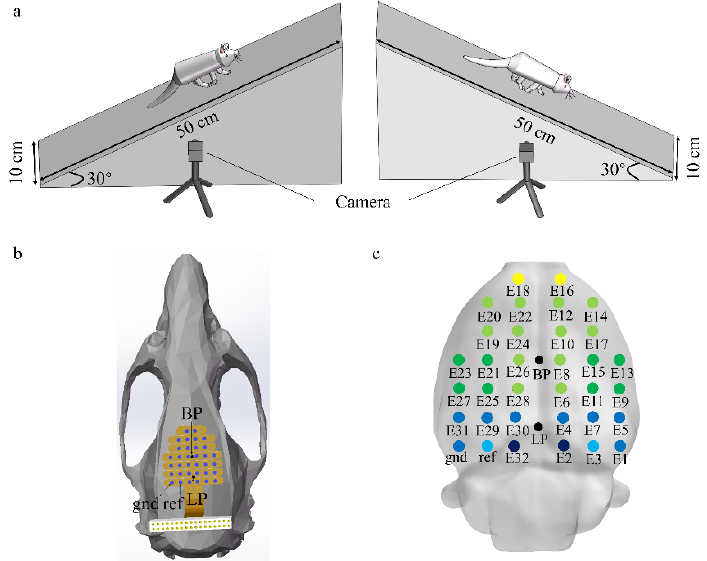
Figure 1. Recording setup and task conditions. ( a ) Characteristics of locomotor paradigms (upslope and downslope walking). ( b ) Electrode location on the rat skull surface; blue dots representing screws that attach the electrode array to the skull; BP represented the bregma point; LP represented lambda point. ( c ) Putative electrode positions on the rat brain, obtained using Brainstorm3. The color of the electrode corresponds to the underlying brain region (yellow: frontal cortex; light green: somatomotor areas; green: somatosensory areas; light blue: visual cortex; blue: posterior parietal association area; dark blue: retrosplenial area).